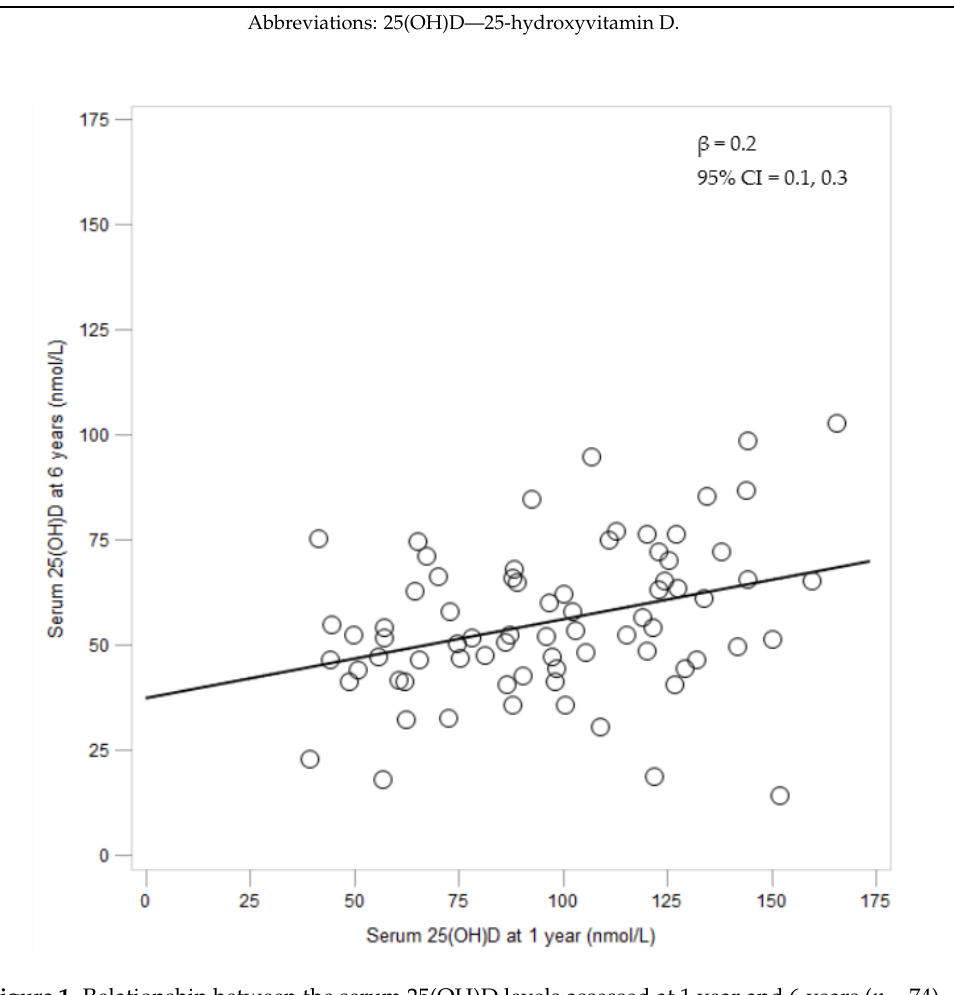
Figure 1. Relationship between the serum 25(OH)D levels assessed at 1 year and 6 years ( n = 74).